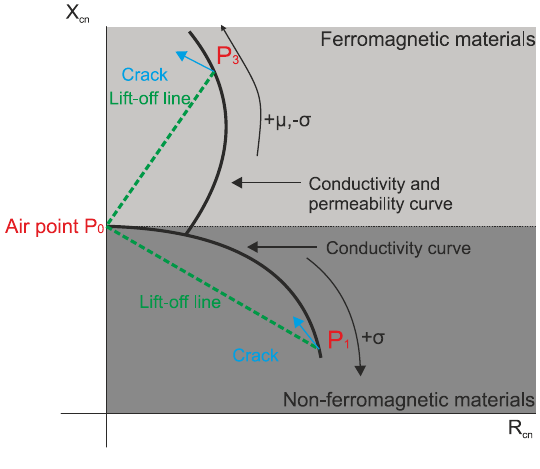
Figure 3. Impedance plane for ferromagnetic and non-ferromagnetic